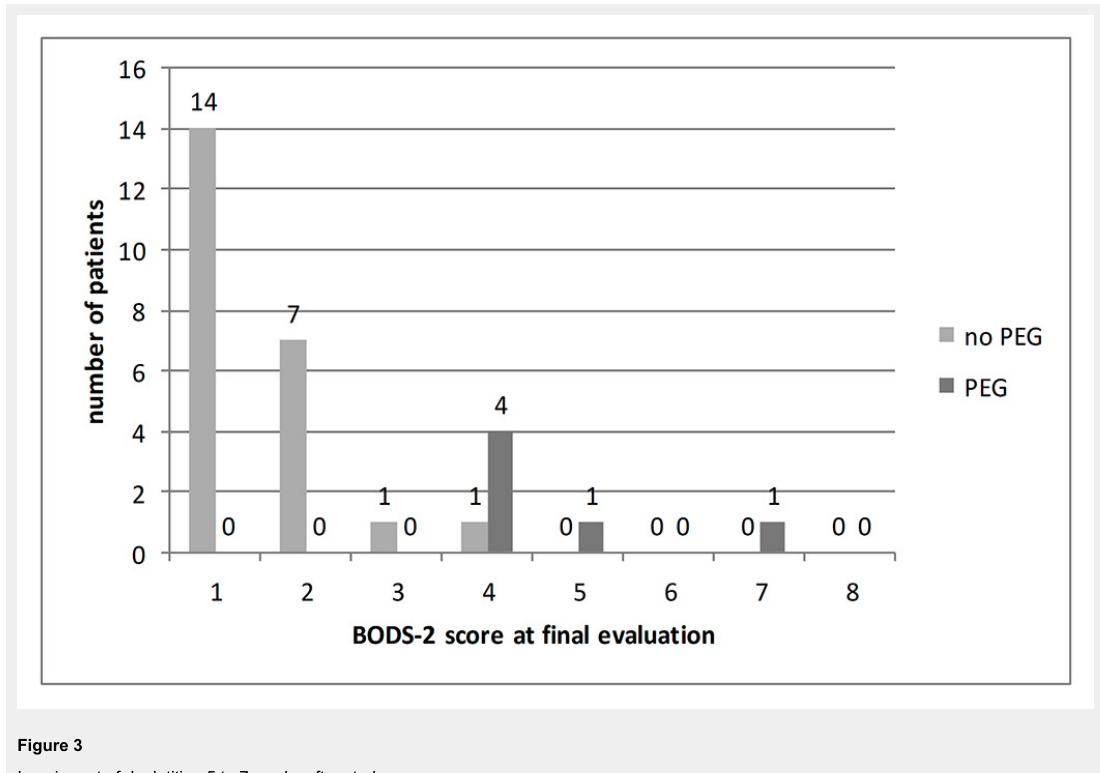
Figure 3 Impairment of deglutition 5 to 7 weeks after stroke. BODS-2 (Bogenhausen-dysphagia-score, part 2) assessed 5–7 weeks after a stroke (final evaluation) in the group with “extended risk of aspiration” (n = 29). PEG indicates individuals with percutaneous endoscopic gastrostomy. Note partitioning into groups (i) BODS-2 <4 and (ii) BODS-2 ≥4. The latter, representing the group of “prolonged impairment of deglutition” (n = 7), had to be predicted from the PHAD